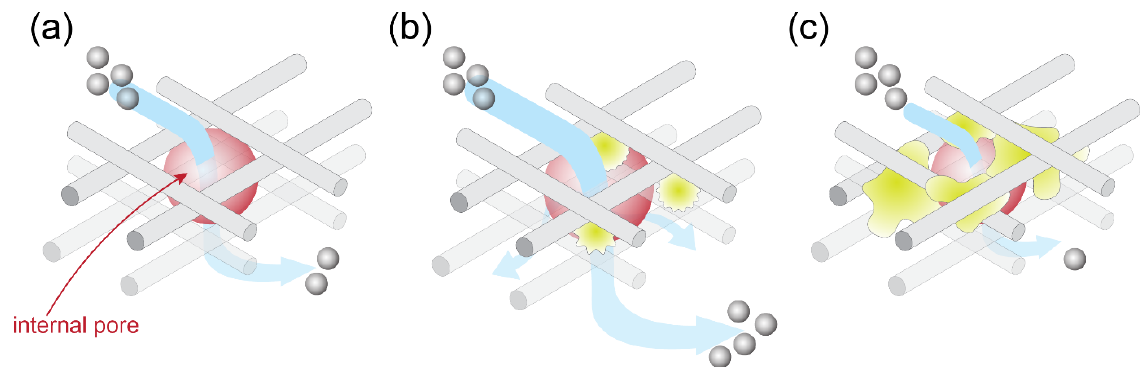
Figure 11. Distribution of lignin inside the CNF matrix, which could explain the observed porosity and gas permeability data ( a ) for the blank CNF–starch network. ( b ) CNF network expanded with weakly interacting lignin particles (yellow; SW/CNF). ( c ) CNF network with strongly interacting lignin molecules covering the fibers and able to disrupt the percolated pathways needed for gas transport but not changing the overall pore structure.